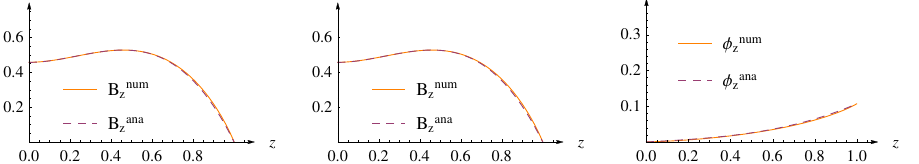
Figure 3. Comparison figures of metric functions A z , B z and scalar field φ z in the numerical (solid curve) and analytical approximate (dashed curve) solutions. Here, we choose horizon radius parame- ter r h = 1, λ = 0.892 and − Λ /3 = 0.457.